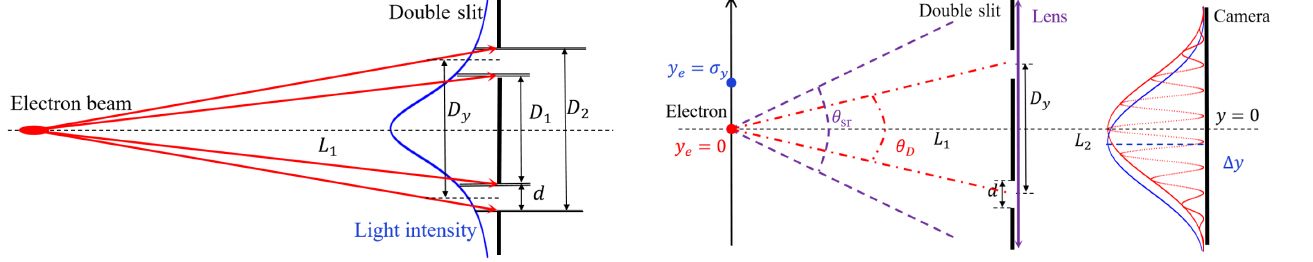
FIG. 4. Illustration of the shifting of the single-slit diffraction envelope on the image plane due to the change of the electron ’ s vertical position. On the left side, the red dashed lines show the opening angle ( θ ) of synchrotron radiation from an in-plane sr ¼ 0 ). The purple dash-dotted lines show the angle electron ( y e ( θ ) subtended by the two slits. On the right side, the red and blue D solid curves represent the single-slit diffraction patterns produced ¼ σ by an in-plane and off-plane ( y ) electron, respectively, with e y the red dotted curve showing the double-slit interference pattern for the